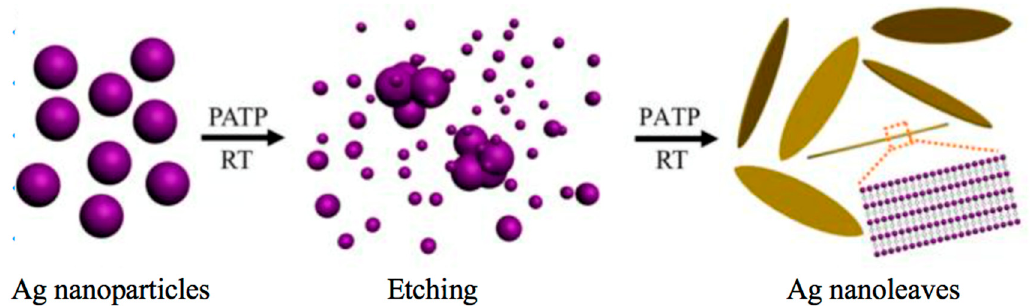
Figure 7. Schematic illustration for the process of etching induced formation of assembled lamellar Ag nanoleaves composed of Ag NCs and p-aminothiophenol (PATP). Adapted with permission from Ref. [48]. Copyright (2013) American Chemical Society.